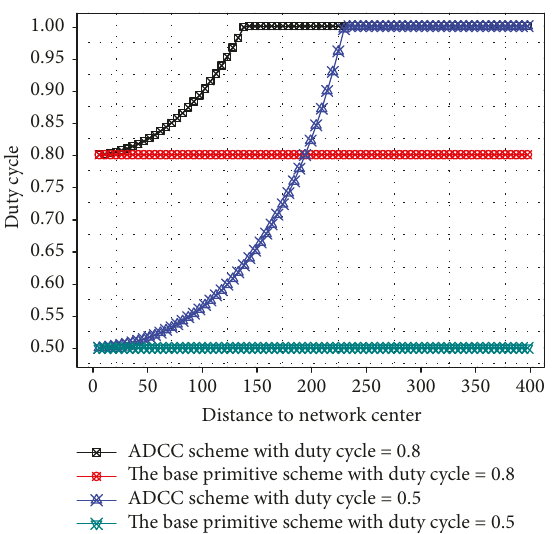
Figure 11: The duty cycle of nodes of network with di ff erent λ .